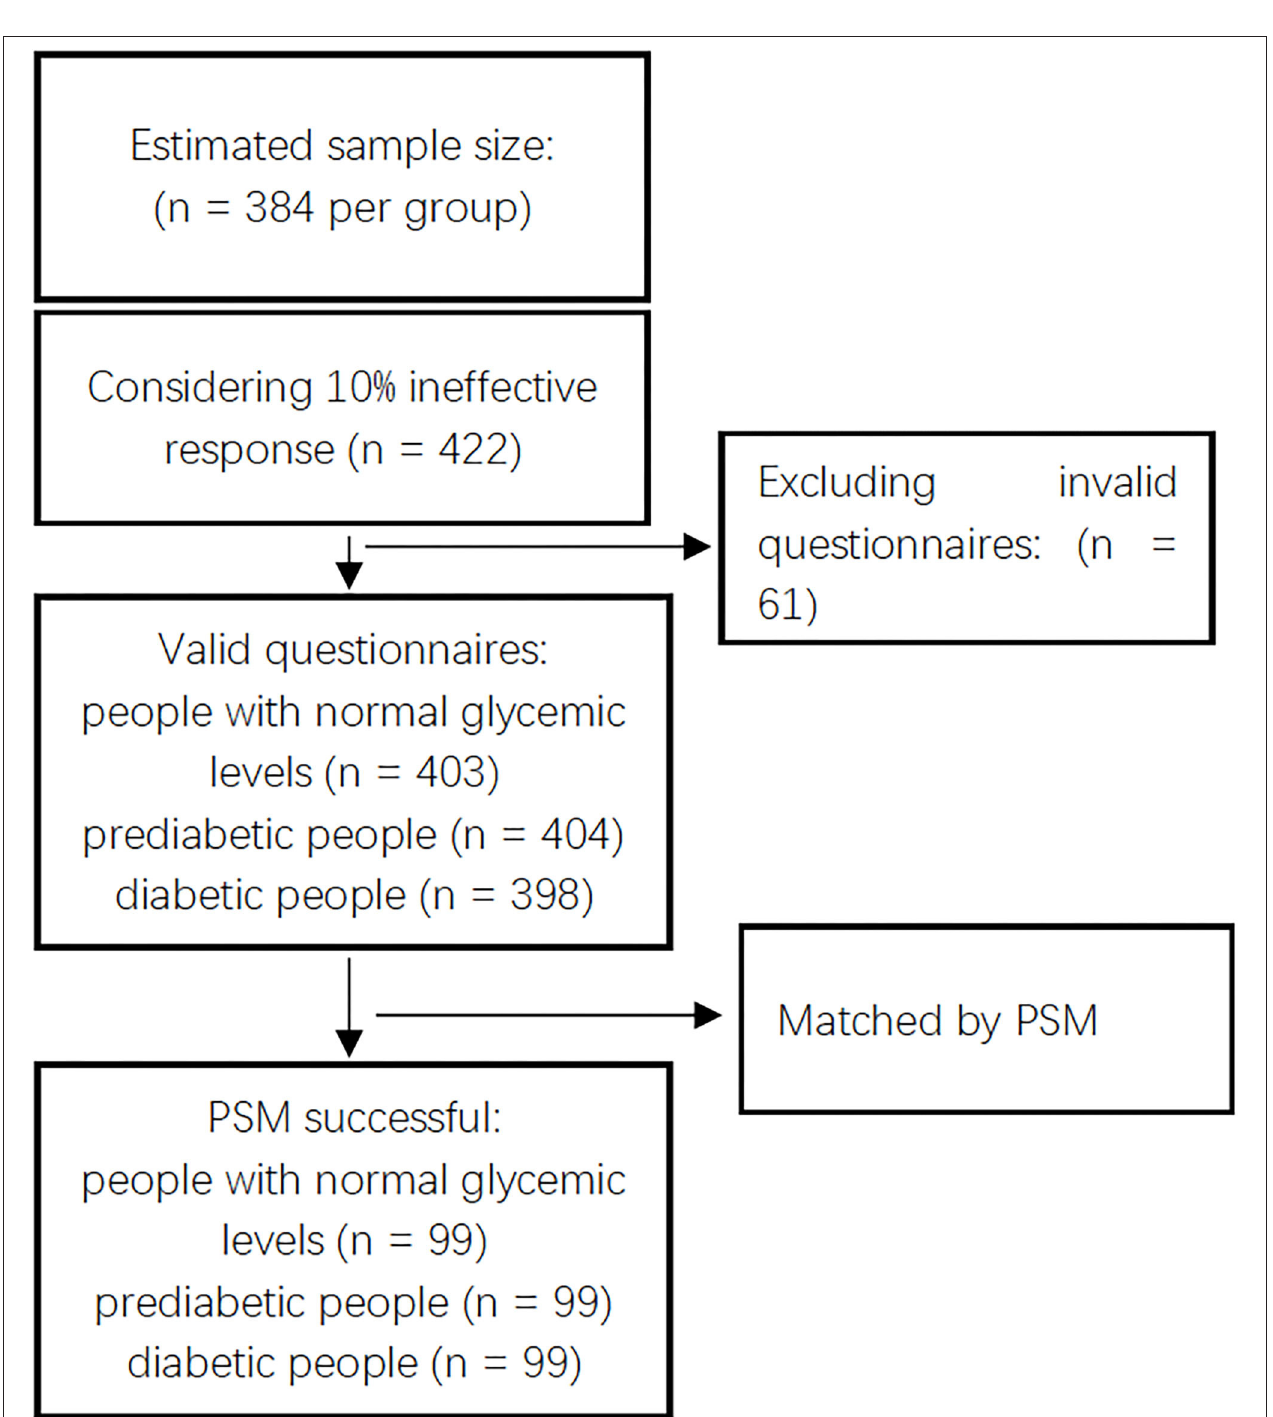
FIGURE 1 | Study flowchart and participants recruited.